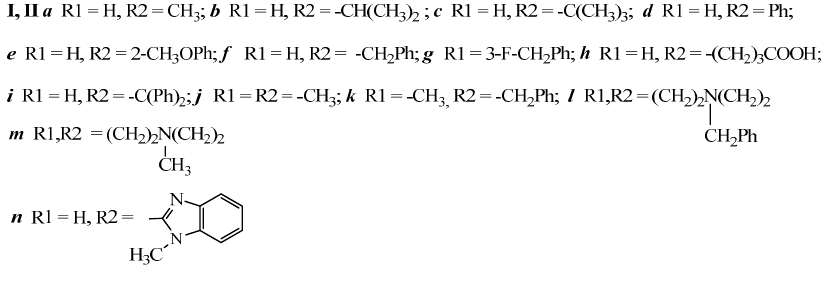
Figure 4. Scheme of the synthesis of sulfanilamide derivatives ( II a – n ).